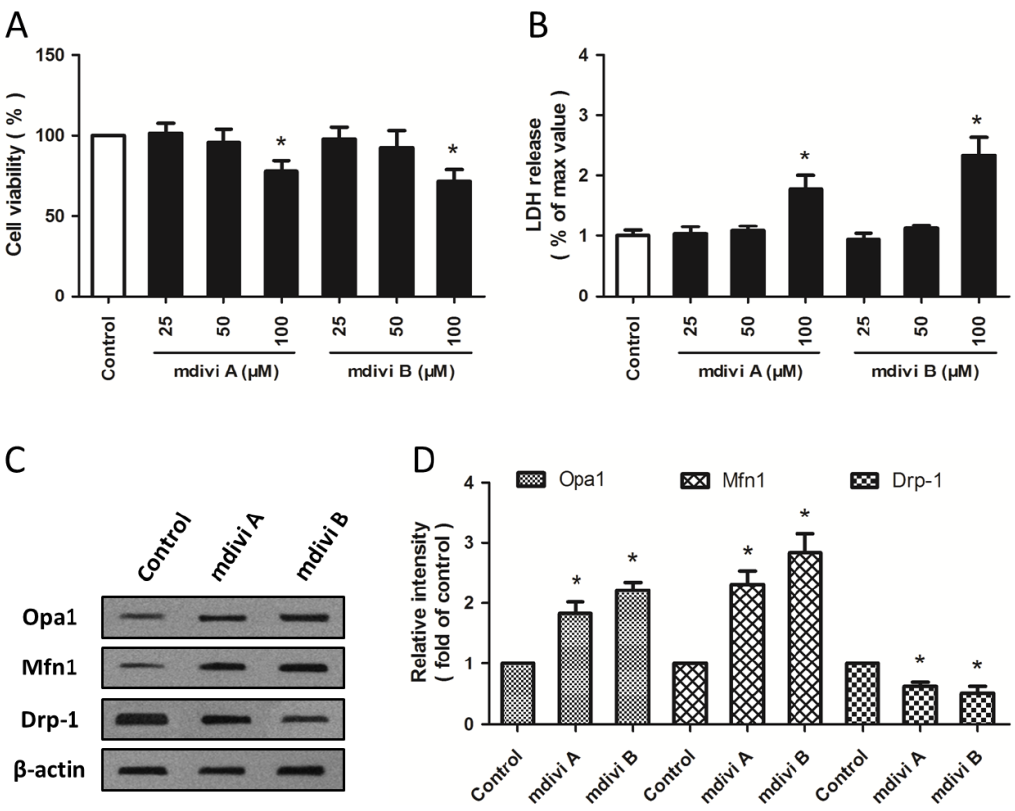
Figure 1. Effects of Drp-1 inhibitors on mitochondrial dynamic proteins. PC12 cells were treated with mdivi A or mdivi B at different concentrations (25, 50 or 100 μM) for 24 h. Cell viability was measured with the WST assay ( A ); and cytotoxicity was measured with the LDH assay ( B ); PC12 cells were treated with mdivi A (50 μM) or mdivi B (50 μM) for 24 h, and the expression of Opa1, Mfn1 and Drp-1 were detected by western blot ( C ) and calculated ( D ). The data were represented as means ± SD from five experiments. * p < 0.05 vs.